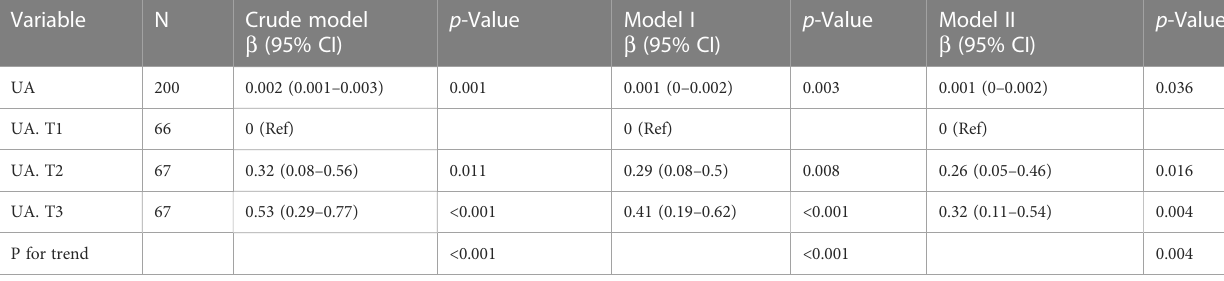
TABLE 3 Association between serum uric acid and phase angle.